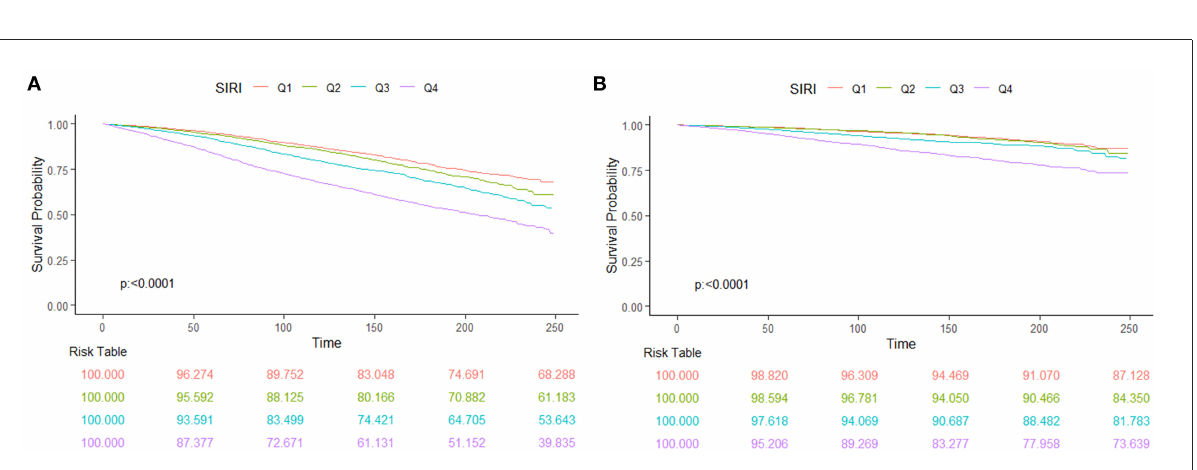
FIGURE3 The Kaplan–Meier curve and risk table for survival probabilities from all-cause mortality (A) and CVD mortality (B) of hypertension